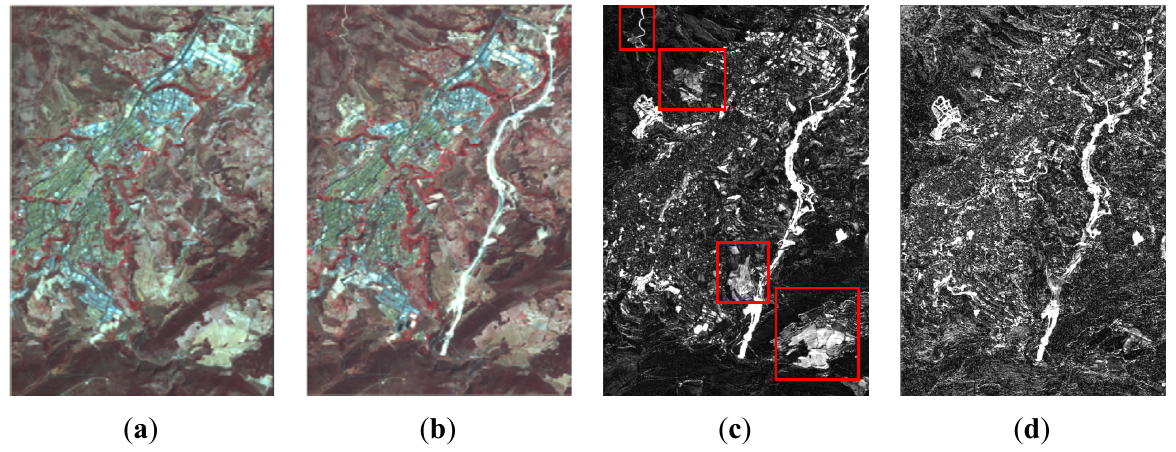
Figure 3. Level 1 processing, SPOT5 XS ( a ) 2005 normalized image; ( b ) 2008 image; ( c ) CD CVA index; ( d ) CD NDVI difference